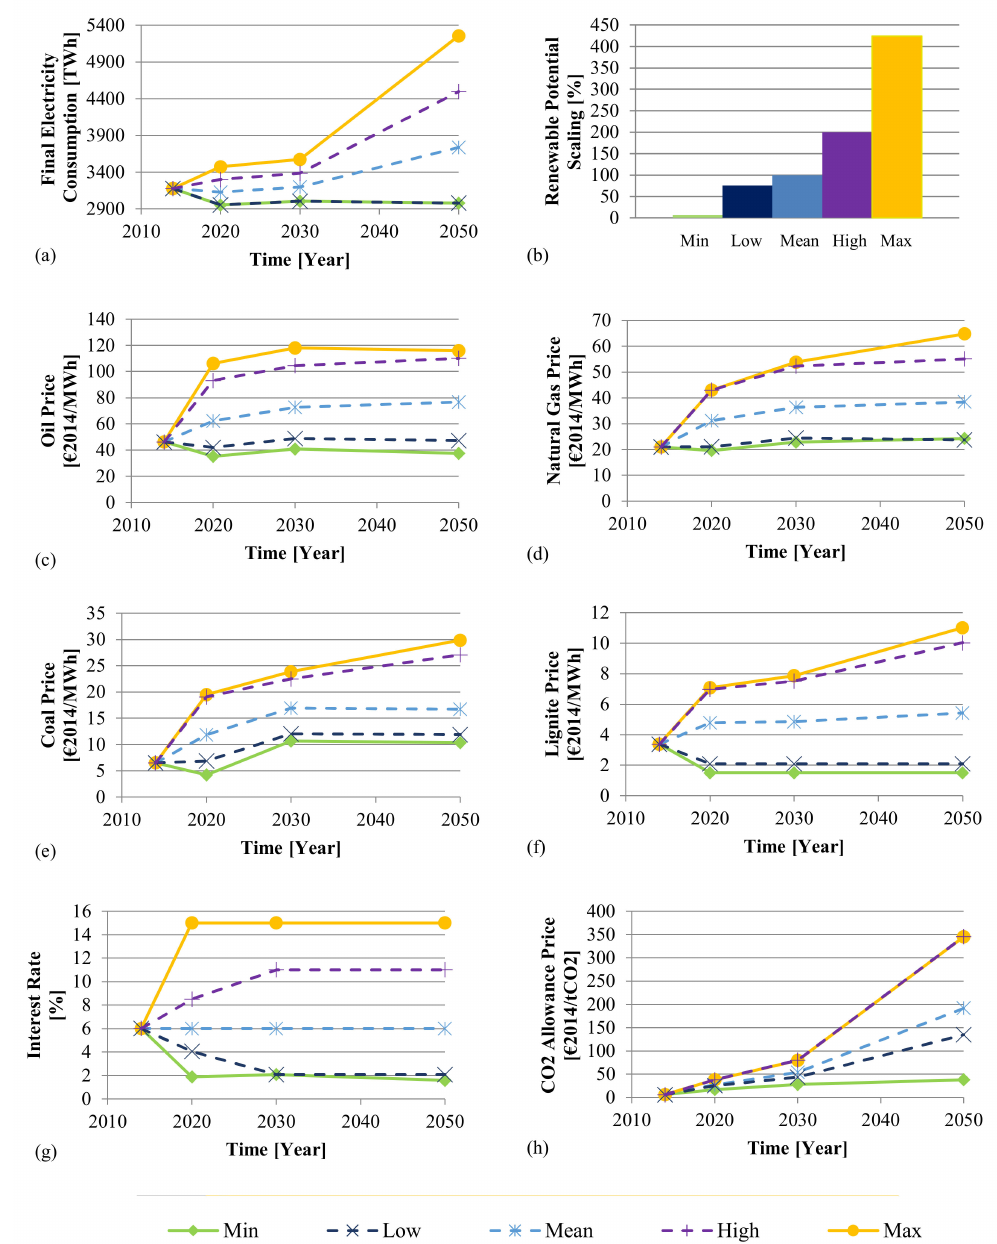
Figure 5. Variable-parameter definition with “Max” and “Min” limit values from literature, and “High”, “Low”, and “Mean” trends for sensitivity-study scenarios. The considered variable param- eters include: Annual power demand described through ( a ) Final electricity consumption; Usable areas for renewable-technology deployment described through ( b ) Renewable potential scaling; Fuel prices described through ( c ) Oil Price, ( d ) Natural gas price, ( e ) Coal price, and ( f ) Lignite price; Interest rate shown in ( g ), and CO2-certificate or allowance prices shown in ( h